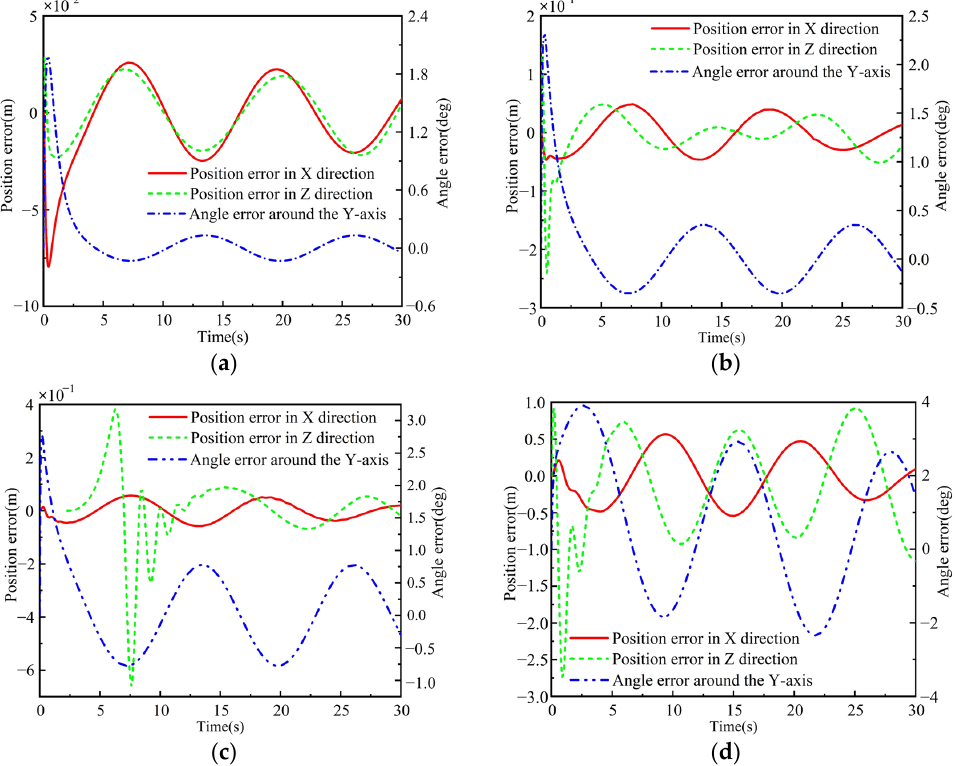
Figure 5. Position tracking error at different speeds: ( a ) Low-speed motion v = 0.6 m/s; ( b ) Medium speed motion v = 3.1 m/s; ( c ) High-speed motion v = 6.3 m/s; ( d ) Ultra-high-speed motion v = 9.4 m/s.